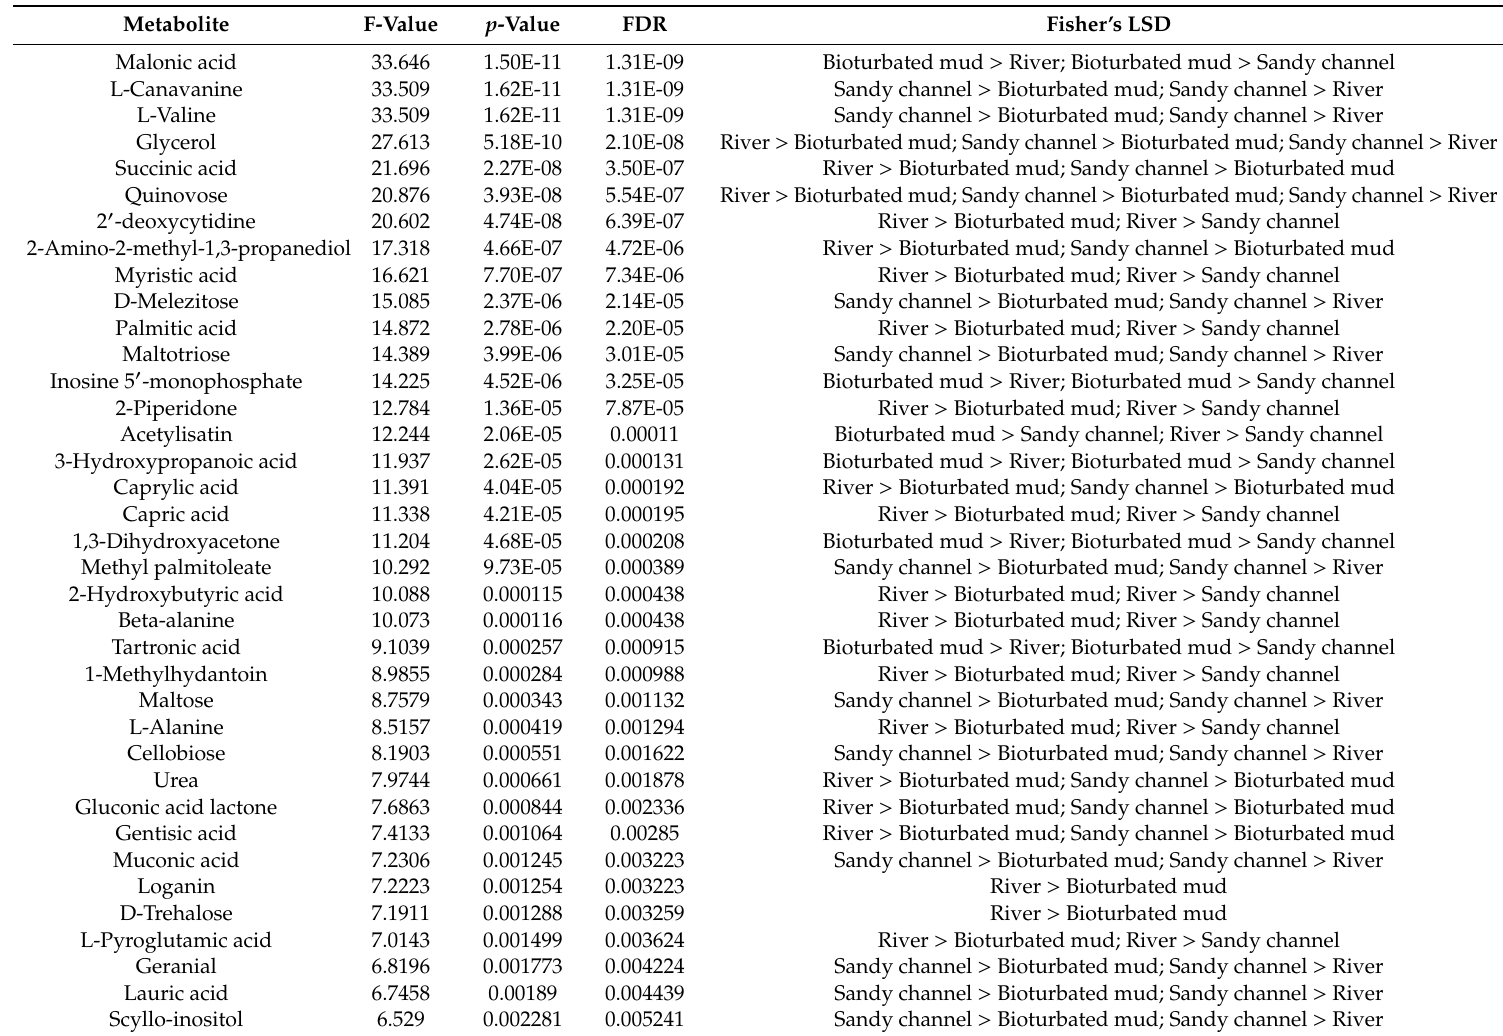
Table 2. Identified significant metabolites from the di ff erent marine sediment habitats sampled from Moreton